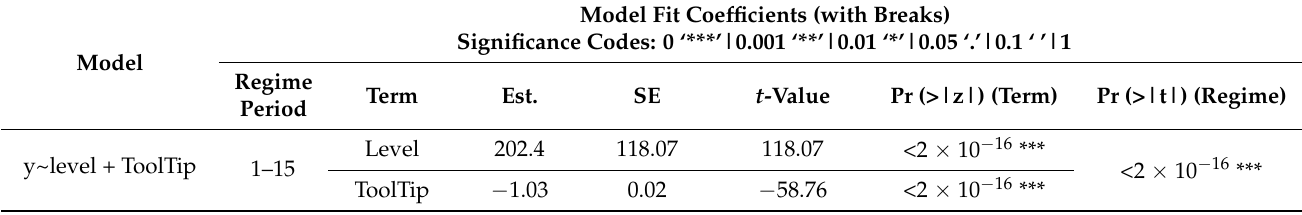
( r Figure 9. Fitted model with determinant variable and no regime change detected. 4.2. Case 2: Gasoline Price and Impact of COVID-19 The second case involves the process of crude oil spot price generation . This process is generated from a complex socio-economic system involving oil producers, transporters, gov- ernments, end-users and several other factors as its components or things. It also includes a complex interaction between these things, which may be in the form of politics, trade and conflicts. The process is socially and economically complex, in which many identified or unidentified process determinants lead to unclear system boundaries and its environ- ment. For now, we treat this system as a blackbox, in which the main output or dependent Rod sequence number D i a m e t e